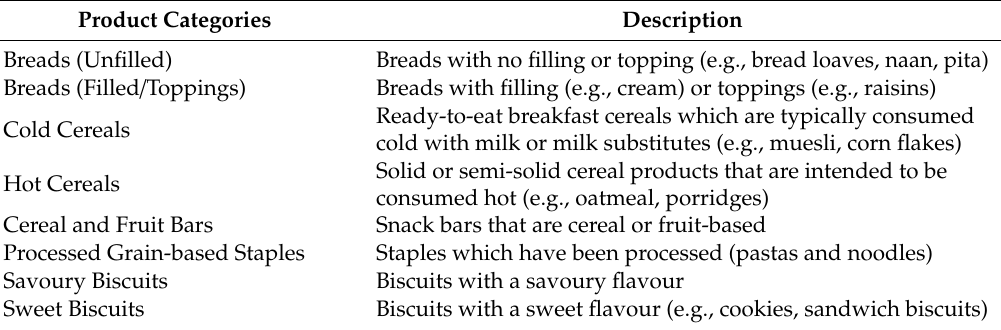
Table 1. Packaged food and beverage categories in the scope of this analysis and their